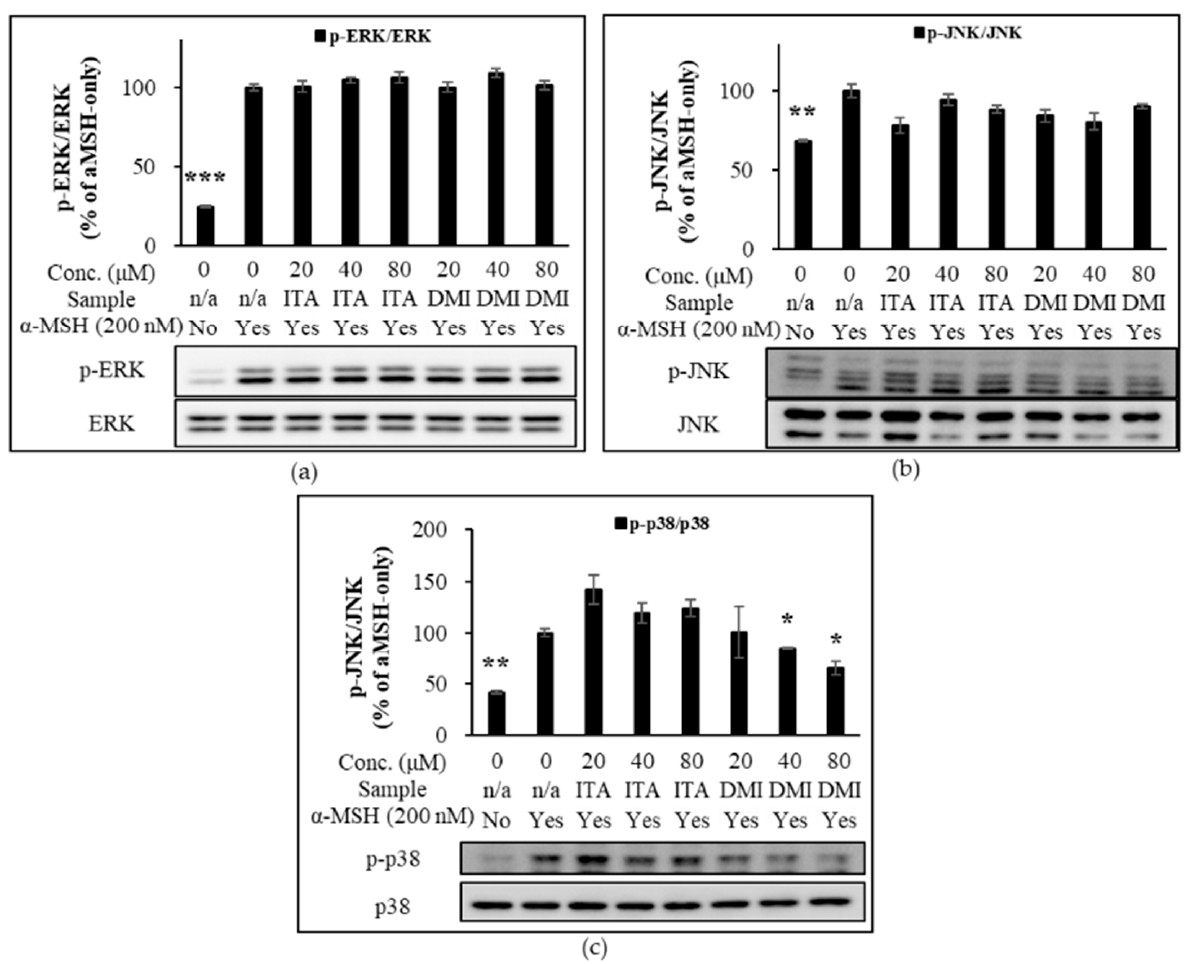
Figure 5. Effect of ITA and DMI on the α -MSH-induced expression of MAPK proteins. The expression level of p-ERK, p-JNK, and p-p38 was respectively normalized to that of total ERK, JNK, and p38. The relative expression level was compared to that of α -MSH only. ( a ) Effect of ITA and DMI on the α -MSH-induced phosphorylation of ERK. ( b ) Effect of ITA and DMI on the phosphorylation of JNK. ( c ) Effect of ITA and DMI on the α -MSH-induced expression of p38. The data were presented as the mean ± standard deviation of three independent experiments; * p < 0.05, ** p < 0.01, *** p < 0.005 compared with α -MSH only.